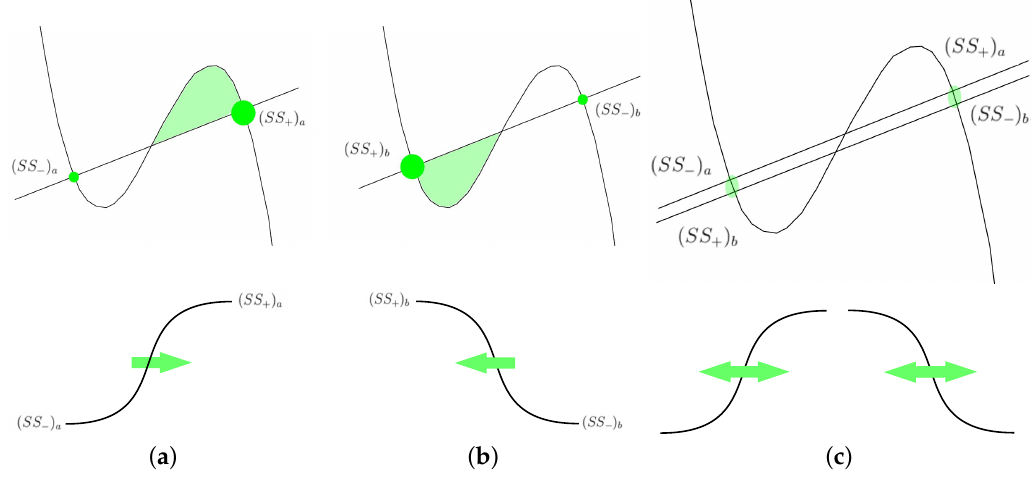
Figure 2. Nullcline representations for a bistable system. ( a ) bistable asymmetric configuration in which the second stable point is the most stable—therefore, in a system endowed with such a configuration, the wavefronts will always travel towards ( SS + ) a ; ( b ) on the contrary, in this case, the first stable point is the most stable; ( c ) both asymmetric configurations are now superimposed, thus exposing the proximity of their stable points.